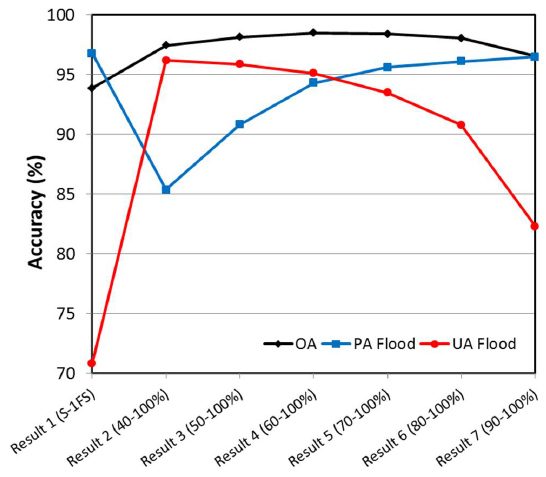
Figure 6. Overall (OA), User’s (UA), and Producer’s Accuracies (PA) of the classification results of the Sentinel-1 Flood Service (S-1FS) and of the improvements using the Sand Exclusion Layers computed with different frequency intervals.